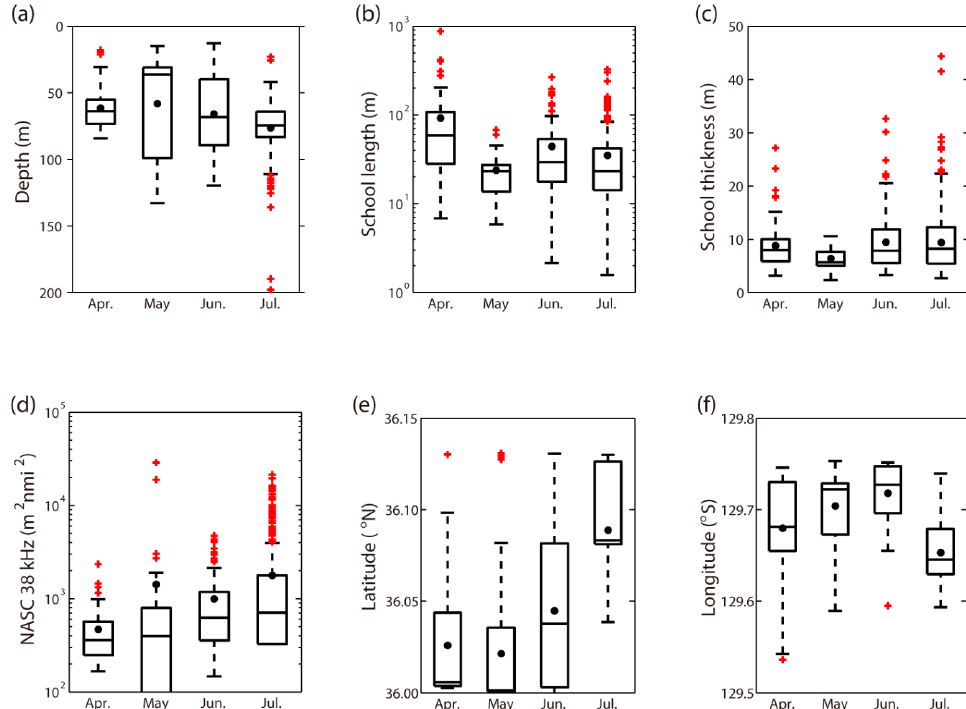
Figure 7. Fish school parameter mean (dashed line), median (solid line), 25th and 75th percentiles (grey box), and outliers (red plus) of ( a ) school depth (m), ( b ) school length (m), ( c ) school thickness (m), ( d ) acoustic backscatter at 38 kHz (NASC, m 2 nmi − 2 ), and ( e ) latitude and ( f ) longitude of fish schools in the coastal southwestern East Sea.